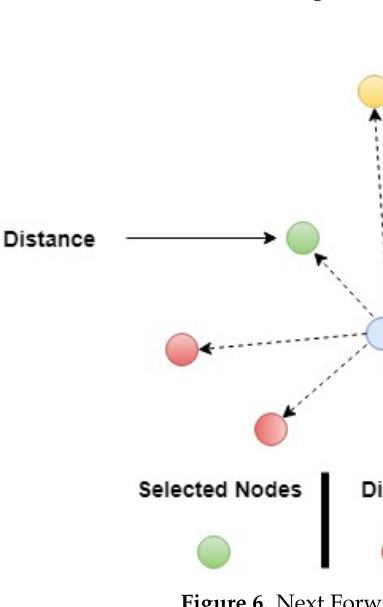
Figure 6. Next Forwarder